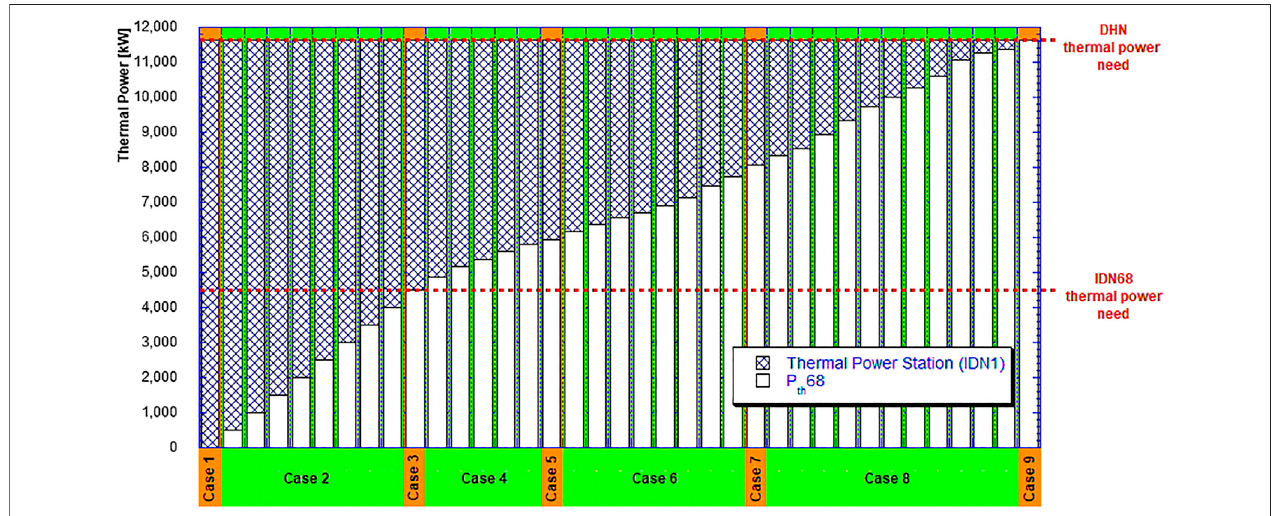
FIGURE 9 | Thermal production, divided between prosumer and thermal power station, for the considered cases. (cid:129) From the design performance evaluation ( Figure 5A ), the user IDN68 results as the critical user, being the one at the end of the path ( Figure 6 ) with the highest pressure losses. (cid:129) The conversion of the user IDN68 into a prosumer allows to reach the highest reduction in both the pumping consumption ( Figure 7A ) and the circulating mass fl ow rate of water ( Figure 7B ). (cid:129) In case of IDN68 as prosumer, the supply pressure can drop to a minimum value which also implies a reduction in the maintenance costs.